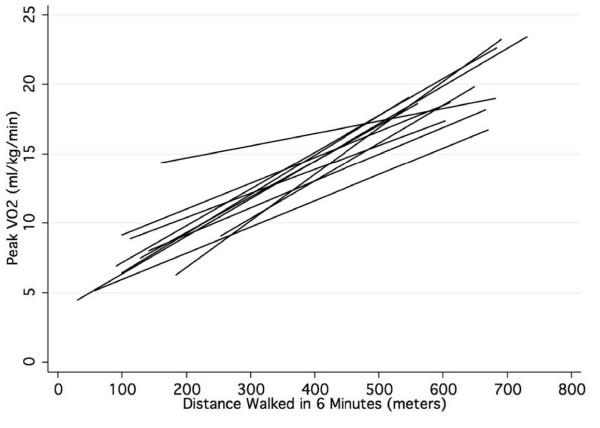
Linear regression lines defining the relation between the distance walked in 6 minutes and peak VO2 for the 11 studies.